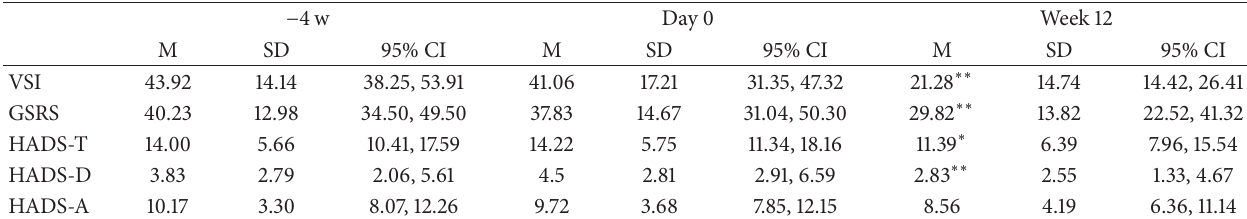
Table 3: Descriptive statistics for questionnaire